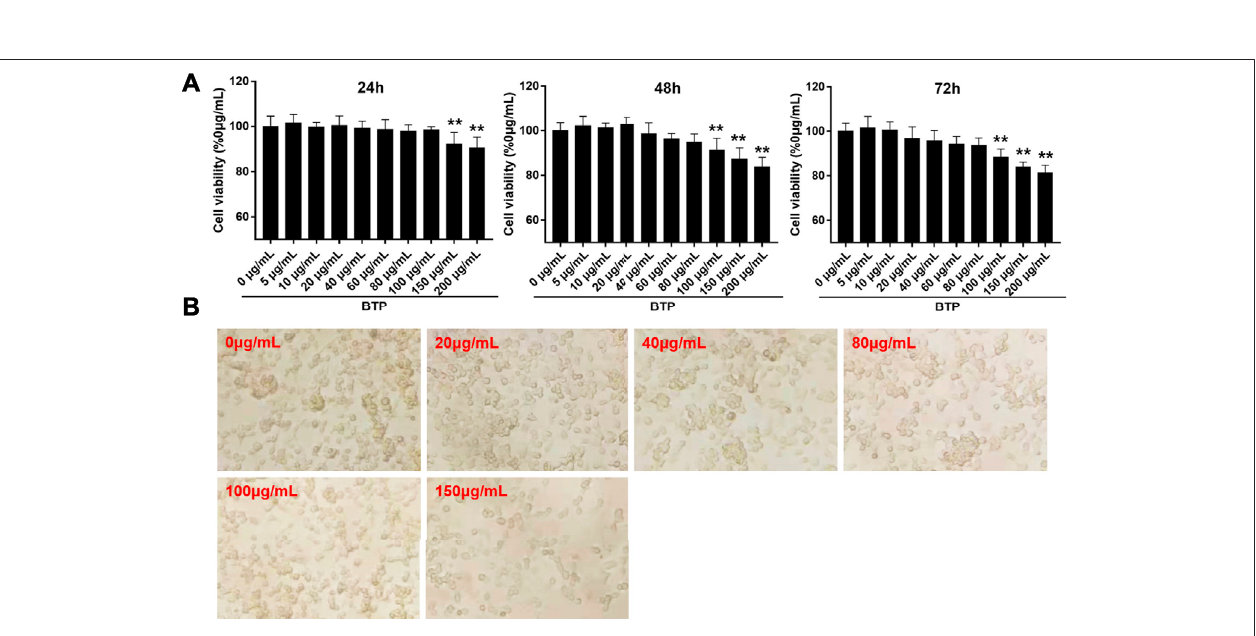
Frontiers in Pharmacology |